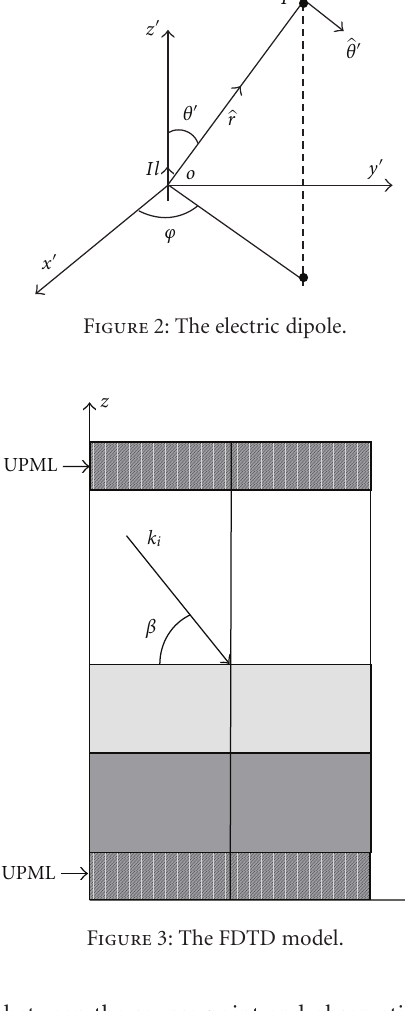
Figure 3: The FDTD